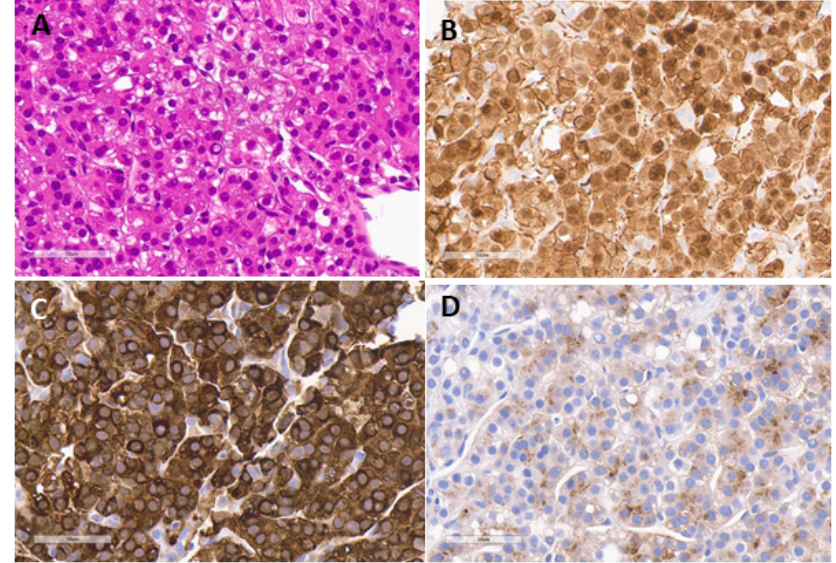
Figure 3. An example of HCN-NOS with overlapping features of HB and HCC in a 11 year old. ( A ) H&E showing a monotonous population of polygonal cells in a trabecular and pseudoacinar arrangement with variable sized nuclei and intranuclear vacuoles (H & E × 400). ( B ) beta-catenin stain shows a mainly cytoplasmic and weak to moderate nuclear stain throughout confirming a possible B-catenin mutation (B-cat × 400). ( C ) strong glutamine synthetase staining, thought to represent a surrogate marker of B-cat mutation (GS × 400). ( D ) Glypican 3 stain confirming the neoplastic nature of the lesion with fine granular staining of cytoplasm (GPC3 × 400).